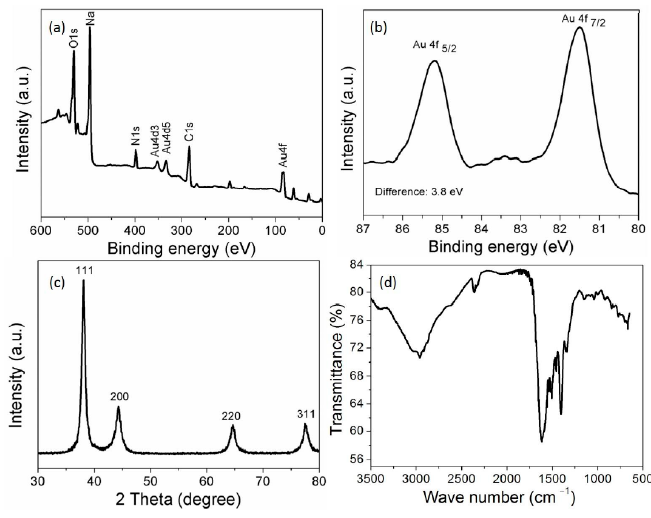
Figure 2. ( a ) XPS survey spectra of AuNPs; ( b ) Narrow scan spectra of AuNPs; ( c ) XRD spectra of AuNPs; ( d ) FTIR spectra of AuNPs.